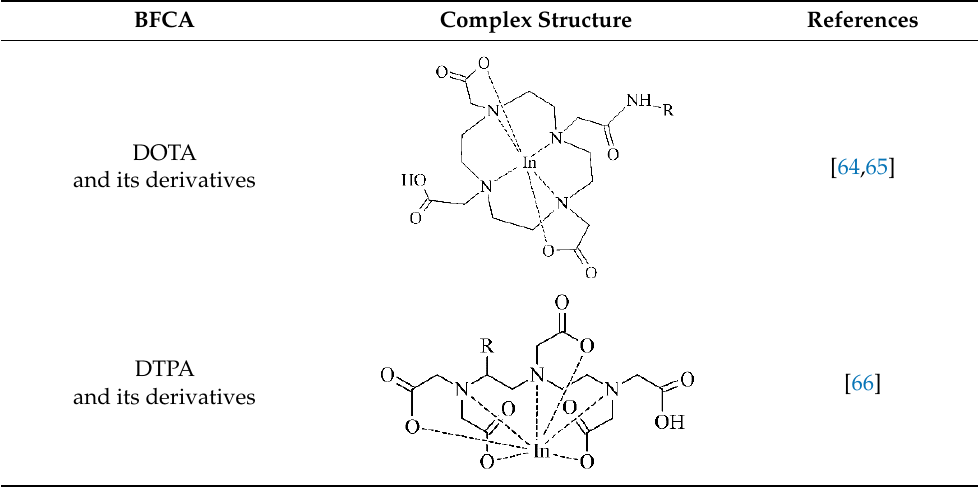
Table 4. The most common BFCA for 111 In-labeled compounds.